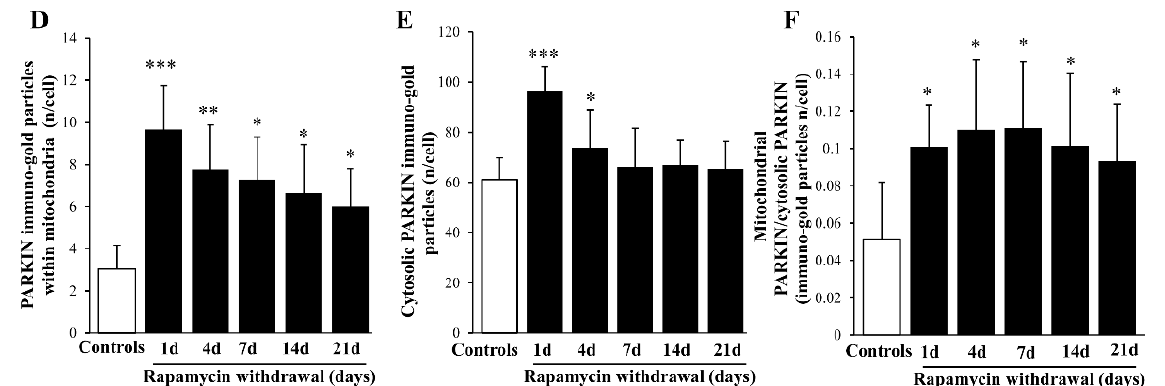
Figure 9. Representative immuno-gold and polarization graphs for PARKIN. Representative TEM micrograph showing PARKIN-positive mitochondria from control ( A ) and following 1 d rapamycin withdrawal ( B ). Arrows point to PARKIN immuno-gold particles within mitochondria. Graphs report the PARKIN-positive mitochondria ( C ), PARKIN immuno-gold particles within mitochondria ( D ), the cytosolic amount of PARKIN ( E ), and the ratio of mitochondrial to cytosolic PARKIN particles ( F ). Values reported in the graph correspond to the mean ± SD. Mitochondria were counted in 50 cells per group. * p ≤ 0.05 compared with controls. ** p ≤ 0.05 compared with controls and 21 d. *** p ≤ 0.05 compared with other groups. Scale Bar = 0.5 μ m, Asterisk (*) = mitochondria, ER = endoplasmic reticulum.